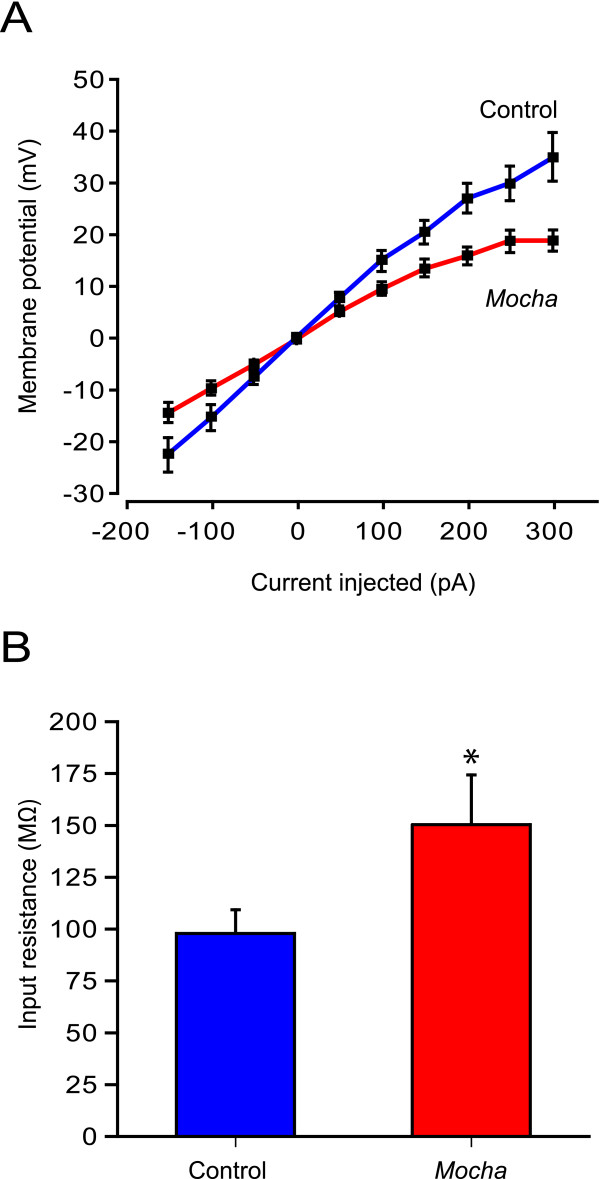
Cultured hippocampal mocha neurons show higher input resistance. A) The passive membrane current-voltage relationship was examined in control and mocha neurons in primary hippocampal culture. In current clamp, positive and negative current injections were made and the membrane potential deflections were measured. The holding potential before current was injected was -60 mV. The graphs result from recordings in control (n = 11) and mocha neurons (n = 13). B) The neuronal input resistances were calculated from the slope of the linear part of the current-voltage curves shown in A). Mocha neurons had higher input resistances, indicating a smaller membrane conductance compared with controls. *: P < 0.05 unpaired t-test. Values are expressed as mean ± SEM.